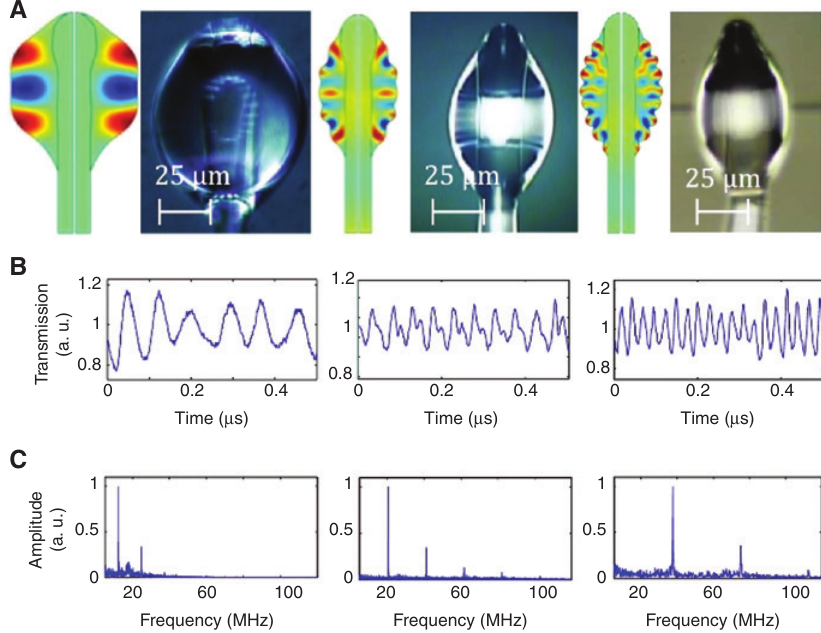
Figure 10: The optomechanics of droplets. (A) Micrographs and acoustic mode patterns for droplets, with 99% of the energy found inside the liquid. (B) Time-domain oscillation meas- urements for the droplets. (C) Frequency-domain oscillation measurements for up to five visible harmonics. Droplet diameters are 40 ± 2 μ m, 50 ± 2 μ m, and 75 ± 2 μ m, while predicted frequencies are 37.54 MHz, 20.57 MHz, and 12.45 MHz. Reprinted from